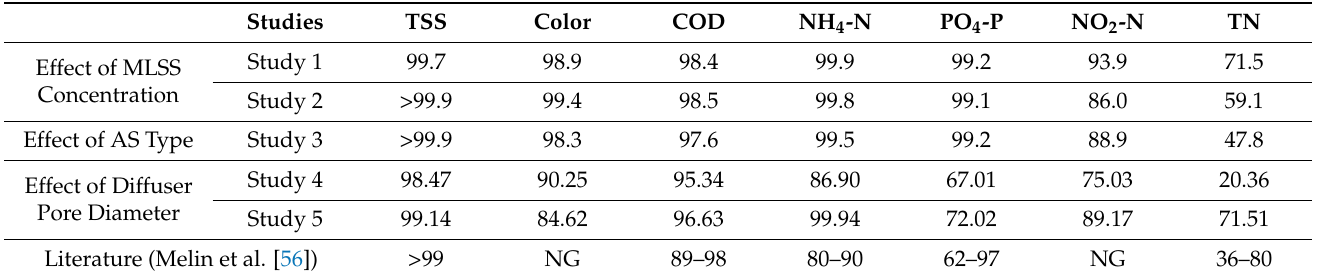
Table 5. Summary of the rejection values of completed tests with pilot MBR